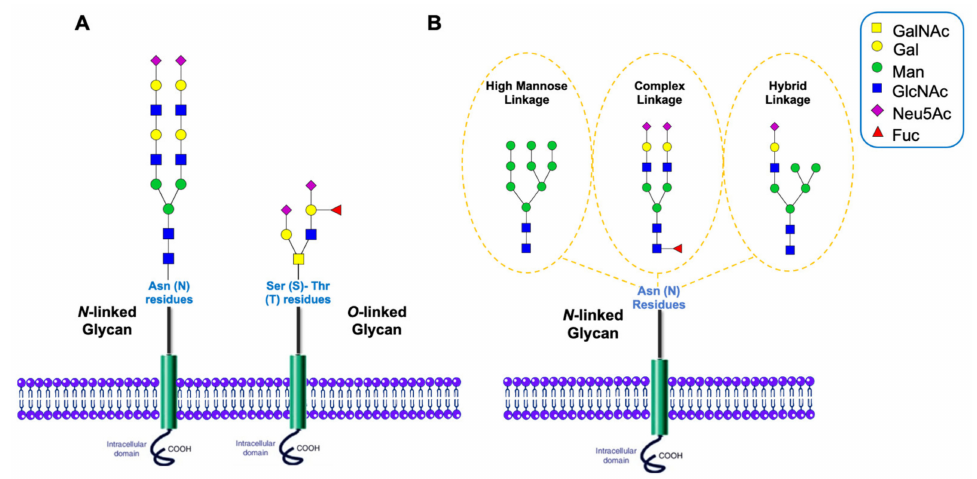
Figure 1. A depiction of the nomenclature, topology, and glycosylation patterns of N - and O -glycans. ( A ) Linkage of N -acetylglucosamine to asparagine amino acid via an N -linked bond, followed by linkage of N -acetylgalactosamine to serine or threonine amino acids via an O -linked bond. The glycoprotein shown is a transmembrane protein. The possible bonds formed between glycan residues are illustrated. ( B ) The three possible types of N -linked glycosylation products, depicted through transmembrane pro- teins. GlcNAc: N -acetylglucosamine; Man: mannose; Gal: galactose; NeuNAc/Sia: N -acetylneuraminic acid/sialic acid; Fuc: